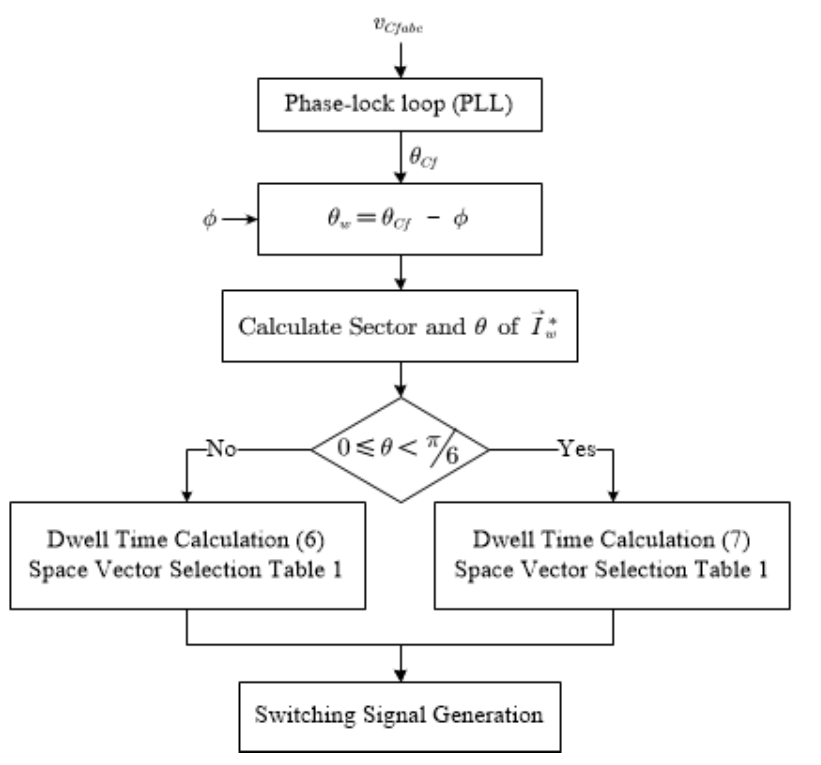
Figure 6. Flowchart diagram of proposed AZS-SVM.